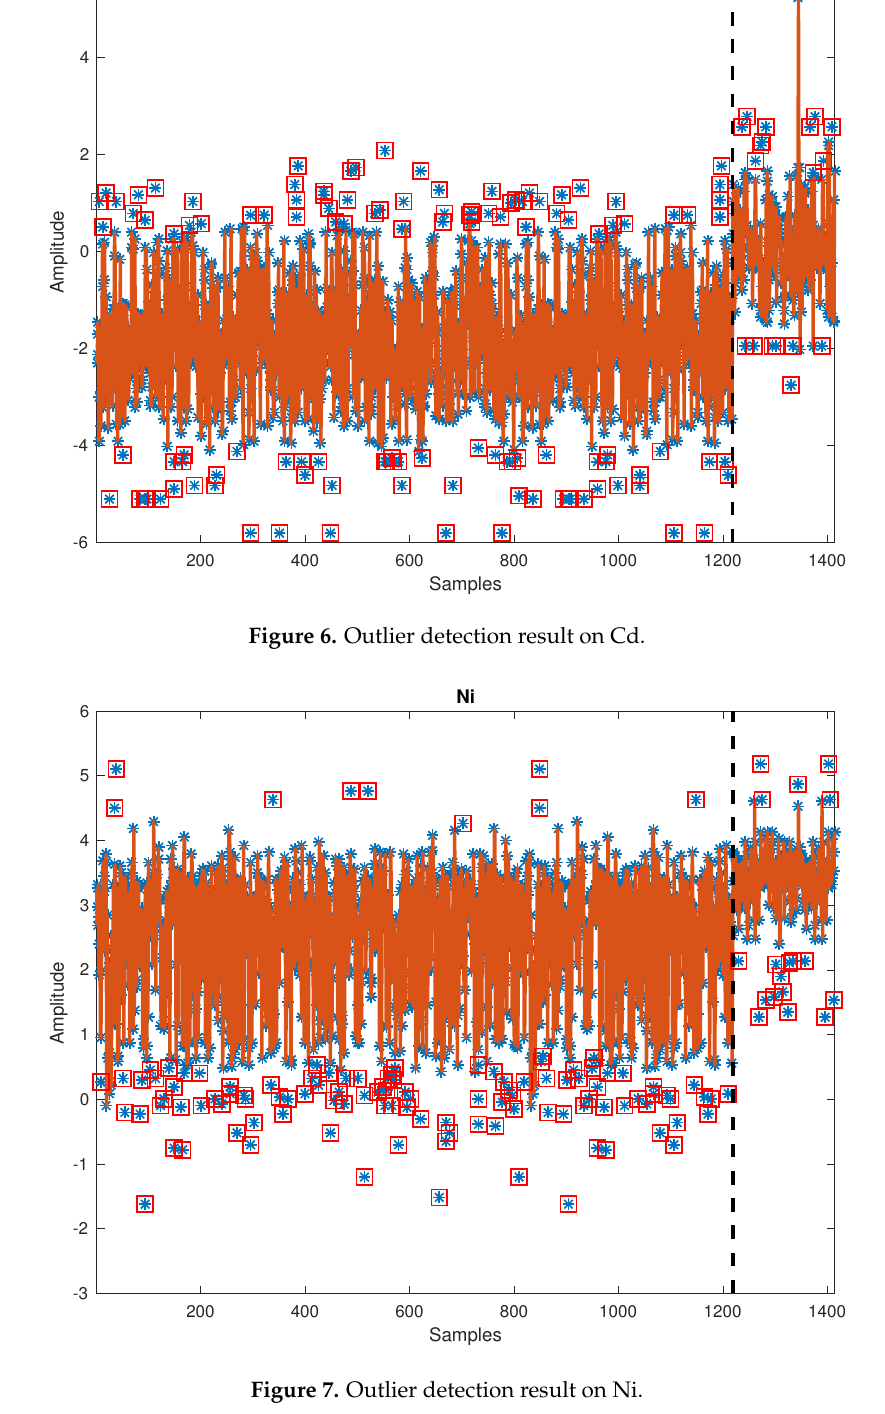
Figure 7. Outlier detection result on